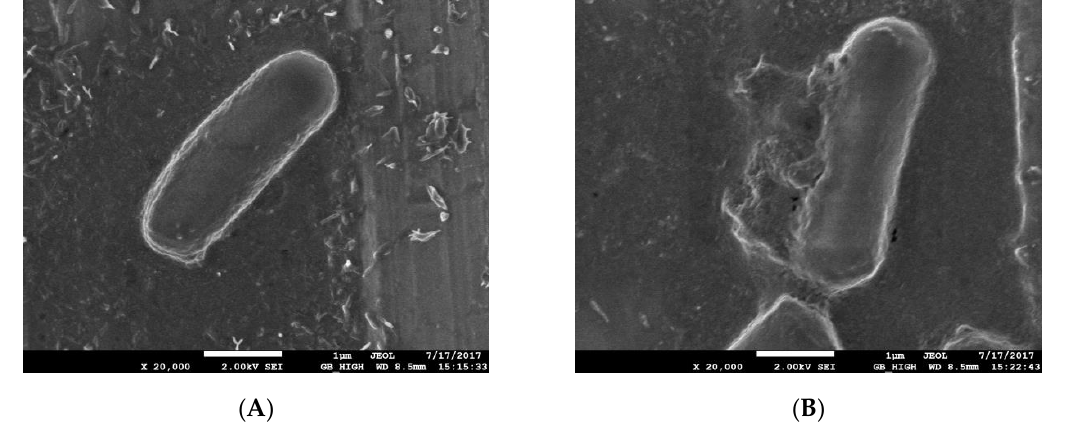
Figure 1. Scanning electron microscopy (SEM) images of E. coli. ( A ). Control E. coli ; ( B ). Treated E. coli.